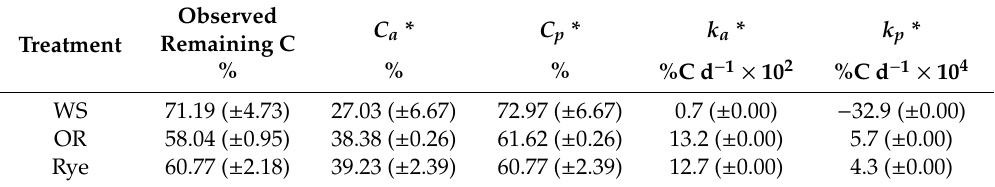
Table 5. Observed remaining carbon (C) in soil with added crop residues after 105 days of incubation, and kinetic coe ffi cients calculated from the double exponential model (Equation (3)). Values in the brackets are standard errors of the mean ( n = 3). Soil mixed with wheat straw (WS), soil mixed with fresh green oilseed rape residues (OR), and soil mixed with fresh green rye residues